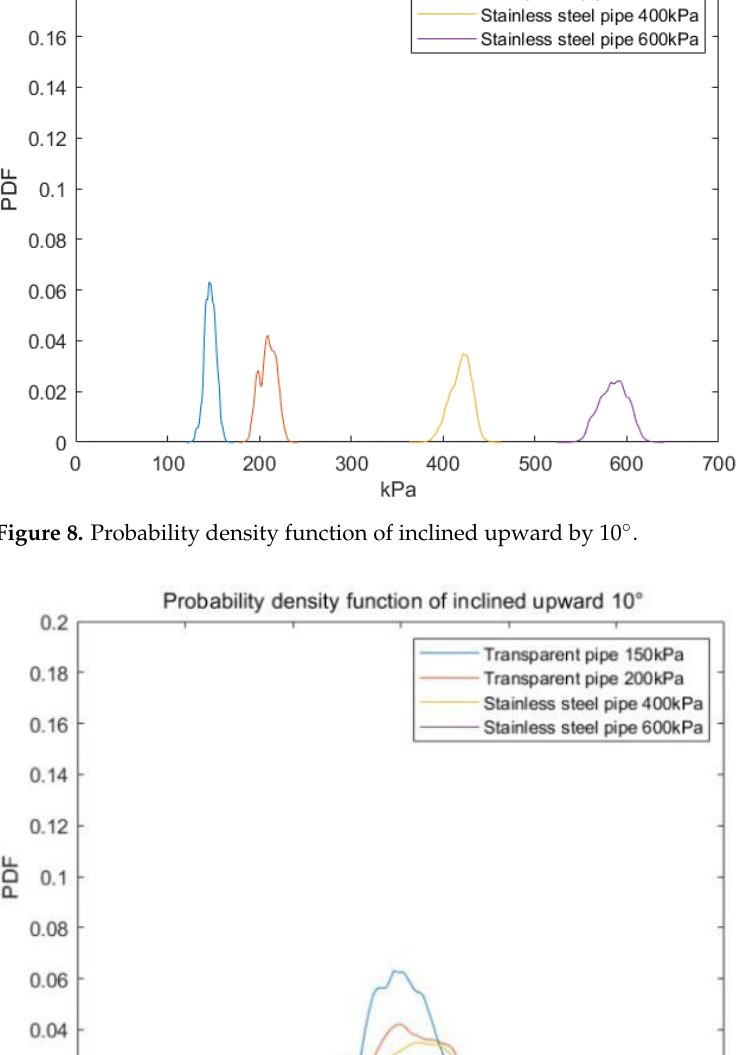
Figure 9. Probability density diagram of pipe pressure minus pipe pressure when inclined upward by 10°.